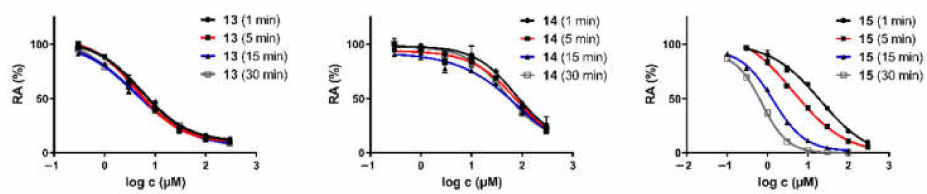
Figure 7. The IC 50 shift curves for compounds 13 – 15 during hBChE inhibition.